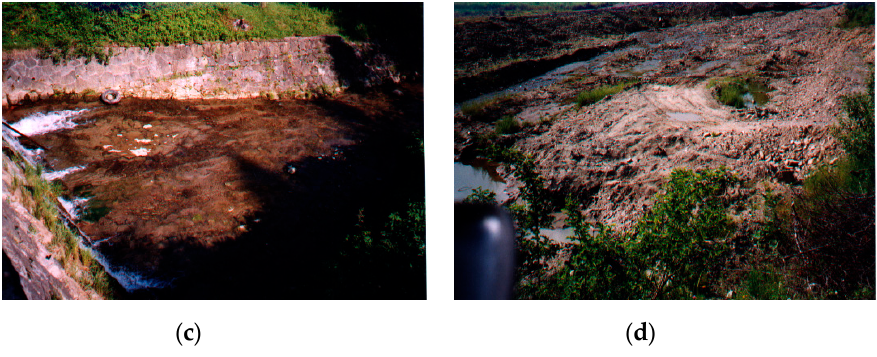
Figure 3. Mlynne stream—cross sections modified with check dam and water reservoir upstream of the check dam. ( a ) check-dam; ( b ) check-dam reservoir with coarse sediment; ( c ) down stream of a check-dam; ( d ) fine sediment in a check-dam reservoir.